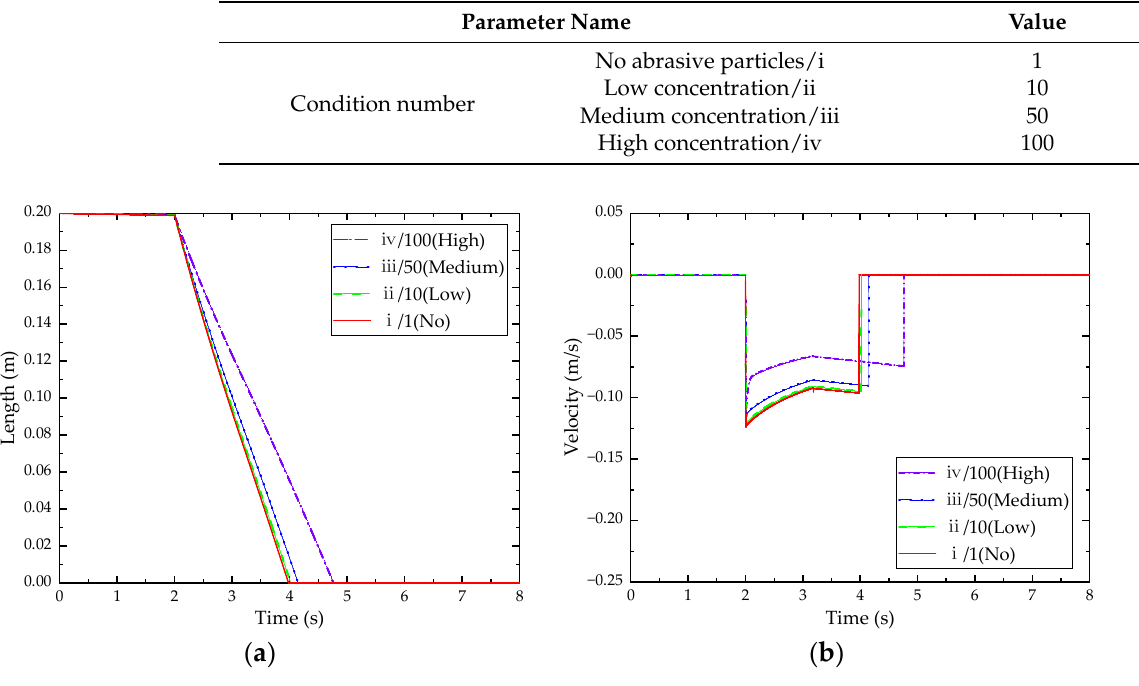
Figure 6. Influence of abrasive particles: ( a ) Piston displacement; ( b ) Piston Velocity. (2) Oil mixed with air.